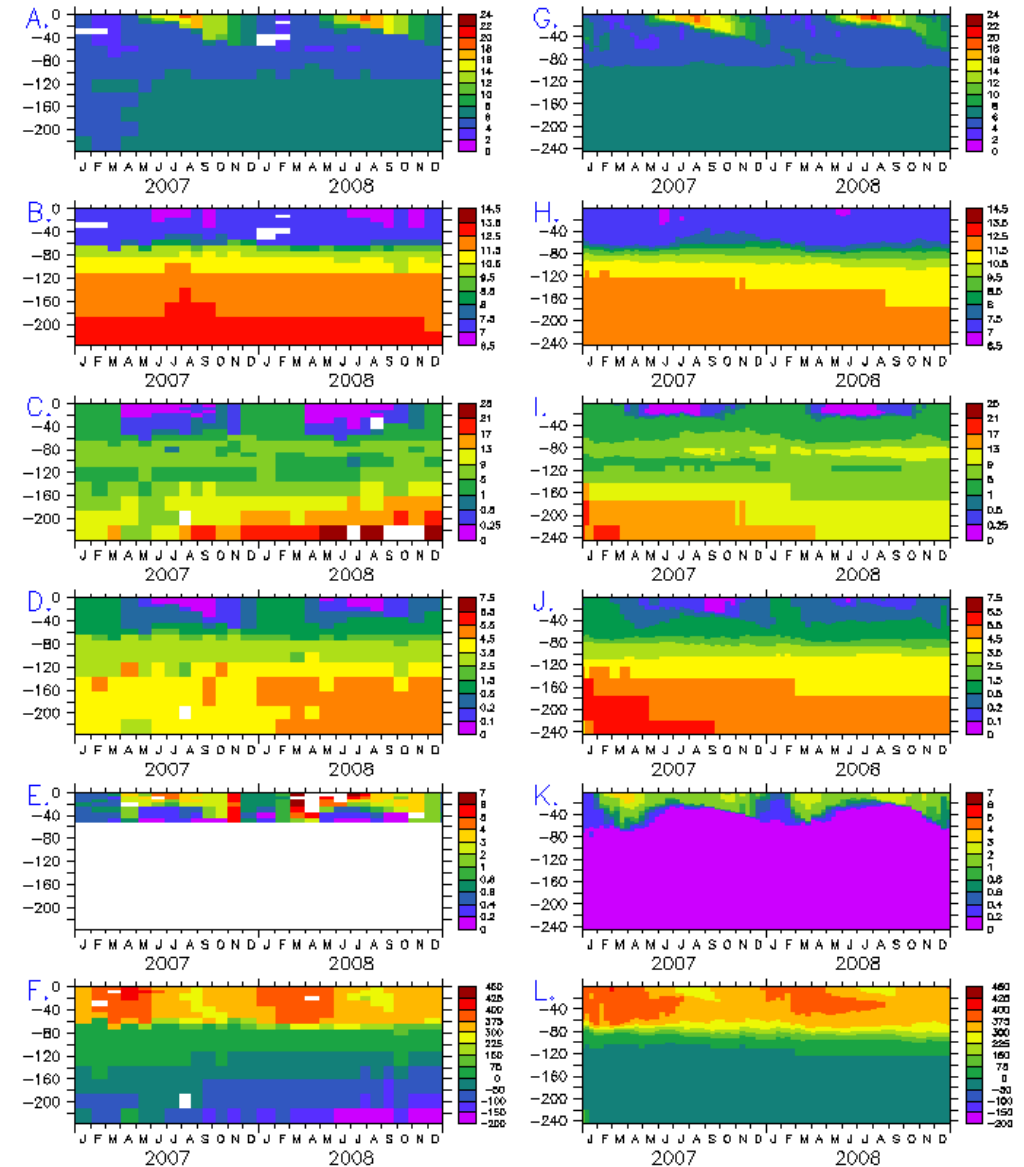
Fig. 13. Temporal evolutions of vertical profile in the Gotland deep at station I. Panels (A–F) for observations of temperature, salinity, DIN, DIP, Chl a , DO, respectively; Panels (G–R) for model results of them. Units: temperature – ◦ C; Chl a – mgm − 3 ; DIN, DIP, DO – mmolm − 3 .